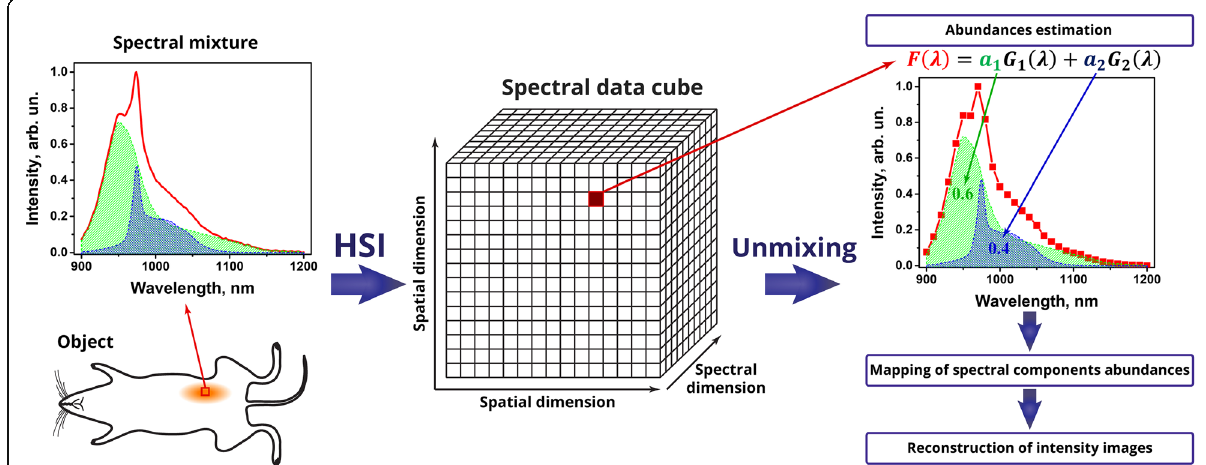
Fig. 1 Scheme illustrating application of HSI for multiplexing photoluminescent